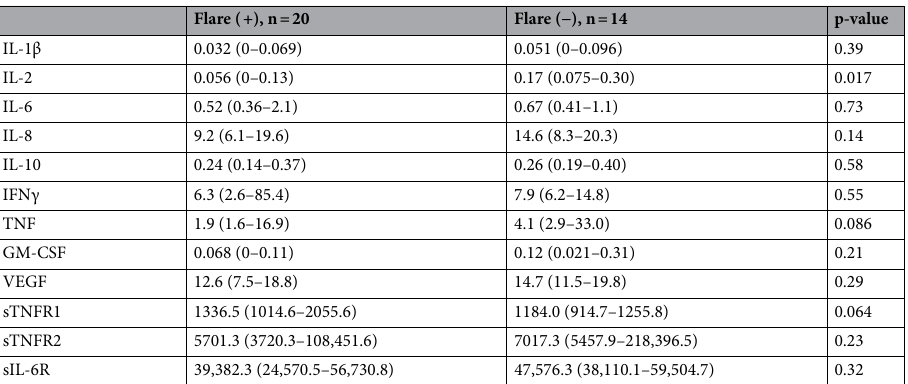
Table 2. Comparison of baseline cytokine and cytokine receptor concentrations between patients who experienced disease flare and those who remained in remission. Values are median (interquartile range), pg/ mL. IL interleukin, IFNγ interferon gamma, TNF tumour necrosis factor, GM-CSF Granulocyte–macrophage colony-stimulating factor, VEGF vascular endothelial growth factor, sTNFR1 soluble tumour necrosis factor receptor 1, sTNFR2 soluble tumour necrosis factor receptor 2, sIL-6R Soluble IL-6